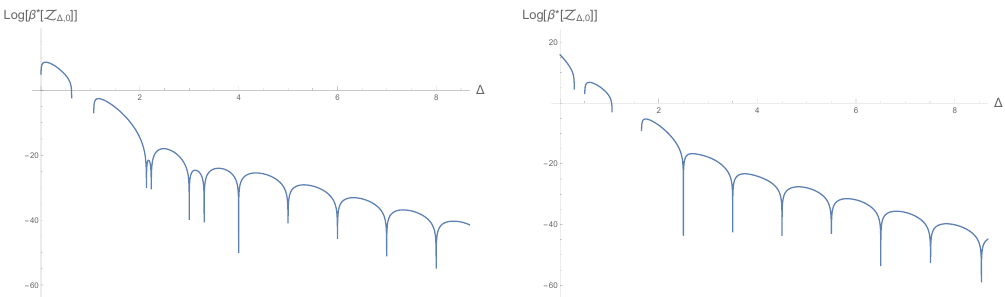
Figure 11 . EFM method applied to the putative CFT with c = 19 spectrum of c = 19 SCFT(left) and spin-half spectrum of c = 19 2